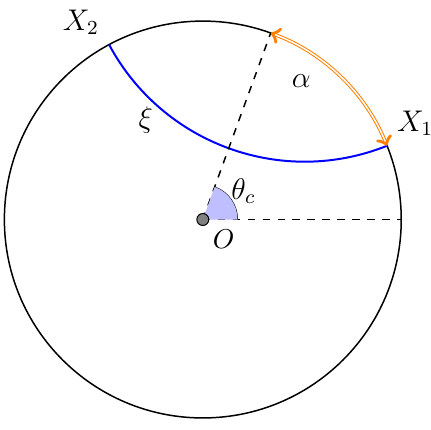
Figure 8 . A pair of points at X 1 and X 2 as a codimension-two defect on a circle at a time slice, and the horocycle (cid:24) in H 2 ending on them at the